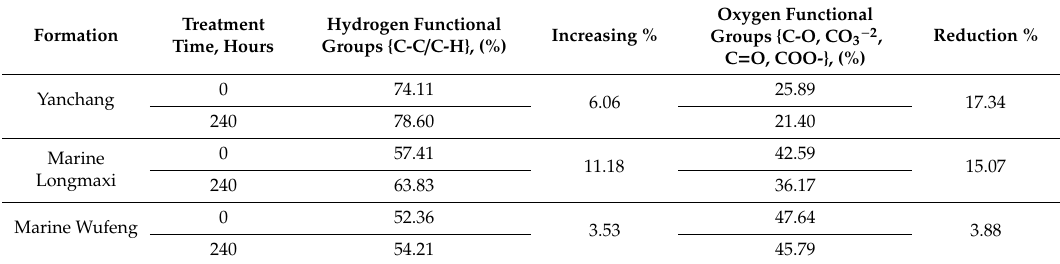
Table 2. Changes in Hydrogen and Oxygen Functional Groups after SCCO 2 saturation